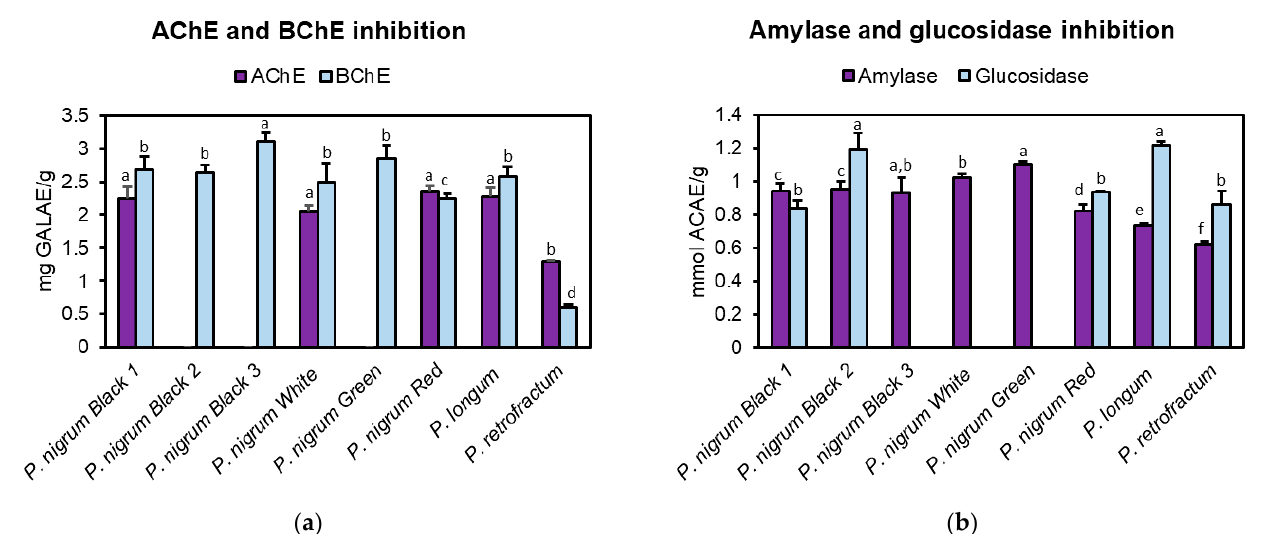
Figure 2. Acetylcholinesterase, butyrylcholinesterase, glucosidase and amylase inhibitory activity of the methanolic fruit extracts obtained from different spices of genus Piper in ( a ) cholinesterase and ( b ) amylase and glucosidase assays. Data are presented as mg galanthamine equivalents (GALAE)/g extract in acetylcholinesterase (AChE) and butyrylcholinesterase (BChE) assays and mg acarbose equivalents (ACAE)/g extract in amylase and glucosidase assays. Each bar represents mean ± S.D. of three determinations; samples sharing different superscript letters are significantly different at p < 0.05.